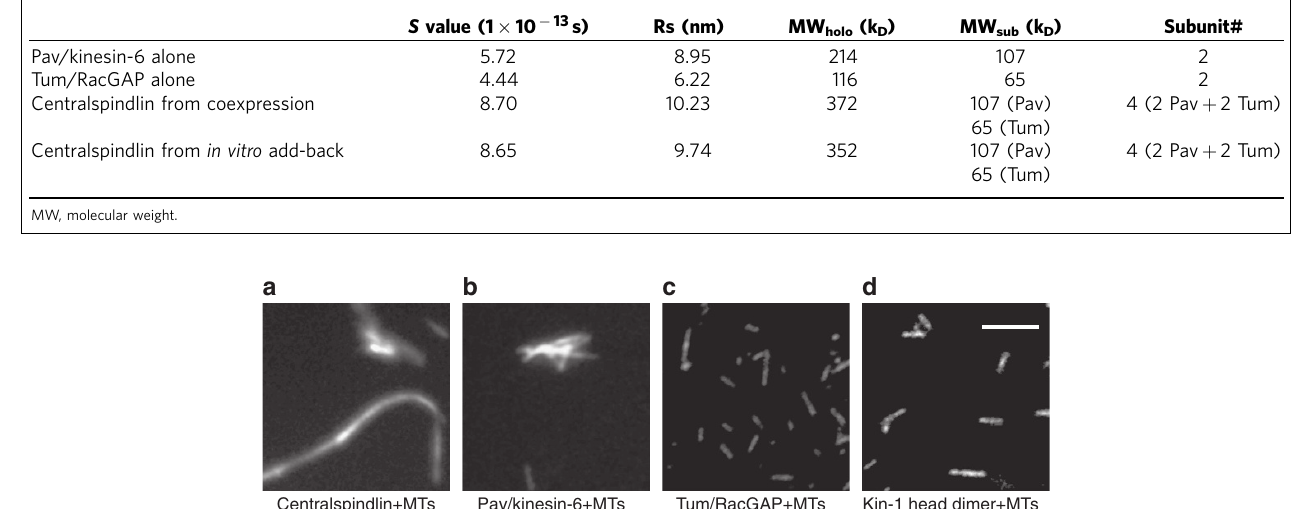
Figure 2 | Purified centralspindlin and Pav/kinesin-6 both bundle MTs. Fluorescence microscopy demonstrates that purified centralspindlin ( a ) and Pav/kinesin-6 ( b ) have obvious bundling activity, while Tum/RacGAP ( c ) or kinesin-1 head dimer ( d ) cannot bundle MTs under the same conditions (1mM ATP and 150mM KCl). Scale bar, 10 m (DDS) and the buffer is supplied with 0.2% Pluronic F127 capable of gliding MTs (Supplementary Movie 6). In contrast, (ref. 23). Under these conditions, centralspindlin cannot attach to the coverslip and glide MTs (Supplementary Movie 5). After anti-His antibodies were applied onto the coverslip to catch and lift 6His-tagged centralspindlin protein, centralspindlin is again